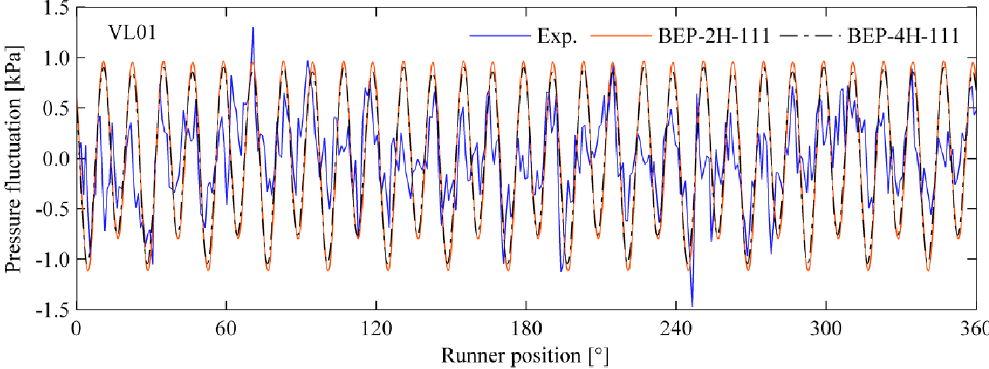
Figure 15. Instantaneous pressure variation in the vaneless space at the BEP [16].